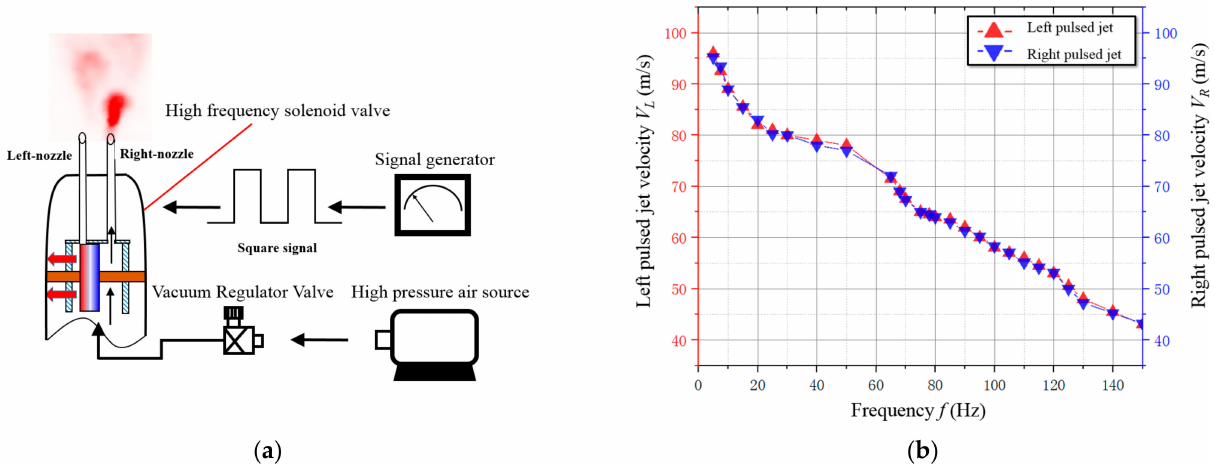
Figure 3. The pulsed jet exciter. ( a ) Structure diagram of pulsed jet generator; ( b ) frequency charac- teristic curve of the pulsed jet